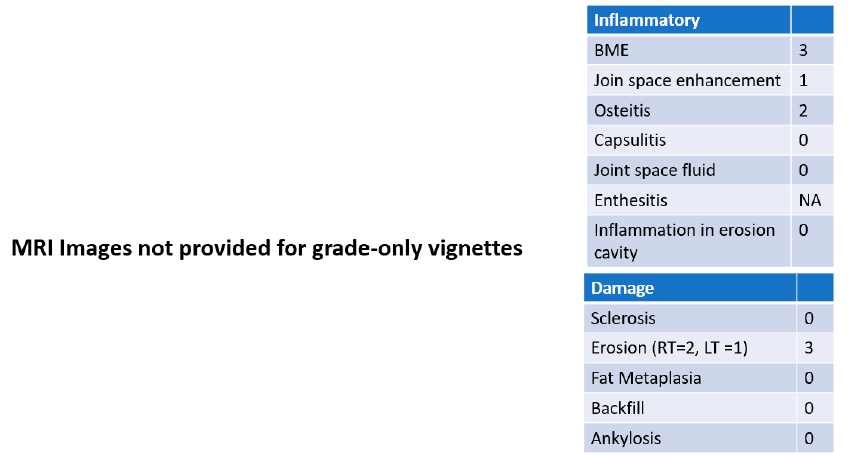
Figure A3. JAMRIS-SIJ image + grade vigne tt e used for ranking exercise to test conjoint analysis survey (CAS)-derived weights. Fourteen image + grade vigne tt es were constructed corresponding to various combinations of pathologies in the JAMRIS-SIJ. Experts individually ranked the cases from the greatest to least level of in fl ammation and damage, respectively.